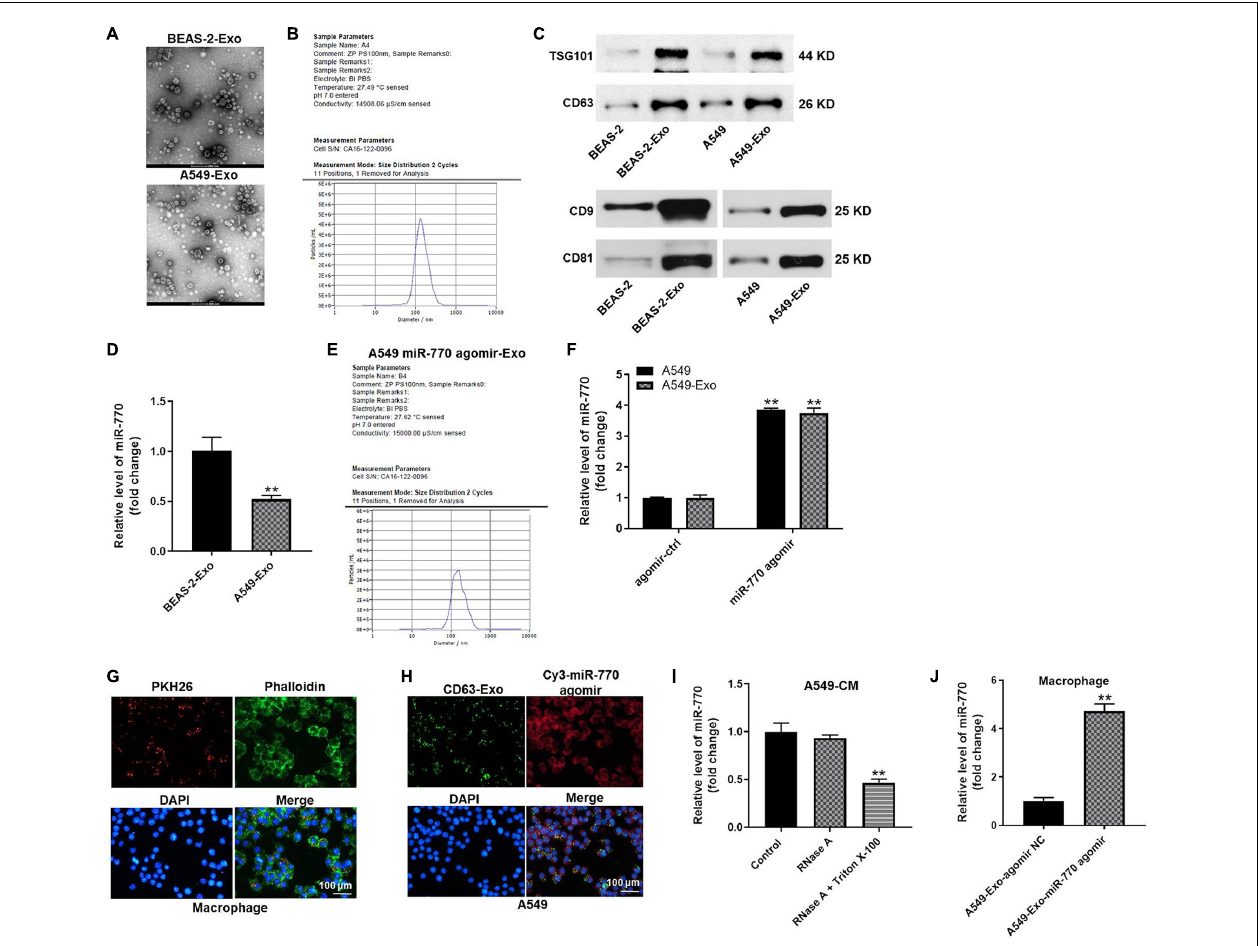
FIGURE 4 | Exosomes were successfully isolated from NSCLC cells. (A) The separation efficiency of exosomes was examined by TEM. (B) The particle sizes of exosomes derived from BEAS-2B (BEAS-2B-exo) were measured by NTA. (C) The expressions of TSG101, CD63, CD9 and CD81 in BEAS-2B, A549 cells, BEAS-2B-exo or A549-exo were detected by western blot. (D) The expression of miR-770 in BEAS-2B-exo or A549-exo was investigated by RT-qPCR. (E) The particle sizes of exosomal miR-770 derived from A549 cells were measured by NTA. (F) The level of miR-770 in NSCLC cells or NSCLC cell-derived exosomes was investigated by RT-qPCR. (G) THP-1 cells were treated with 100 ng/ml PMA, and then co-cultured with A549 cell-derived exosomes. Then, the location of exosomes was observed by immunofluorescence staining. (H) GFP-CD63 and fluorescence labeled miR-770 agomir were co-transfected into NSCLC cells. Then, exosomes were isolated and added into macrophages. The location of exosomes was observed by immunofluorescence staining. (I) The level of miR-770 in CM of macrophages/miR-770 treated with RNase alone or RNase plus Triton X-100 was detected by RT-qPCR. (J) The level of miR-770 in macrophages was detected by RT-qPCR. N = 3; ∗∗ P < 0.05 compared to